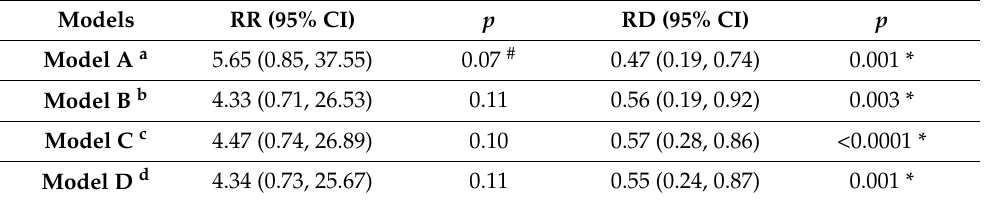
Table 2. The effectiveness of β -glucan ointment on wound healing.